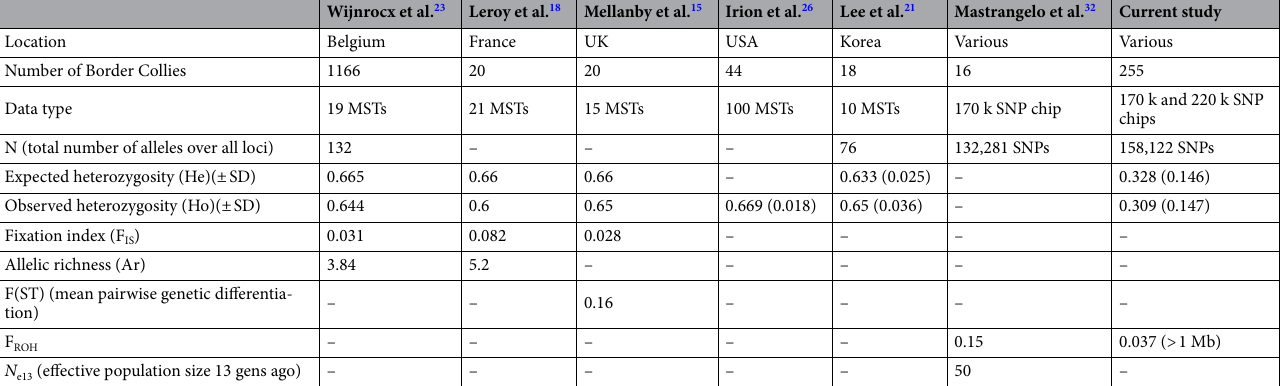
Wijnrocx et al. 23 Leroy et al. 18 Mellanby et al. 15 Irion et al.